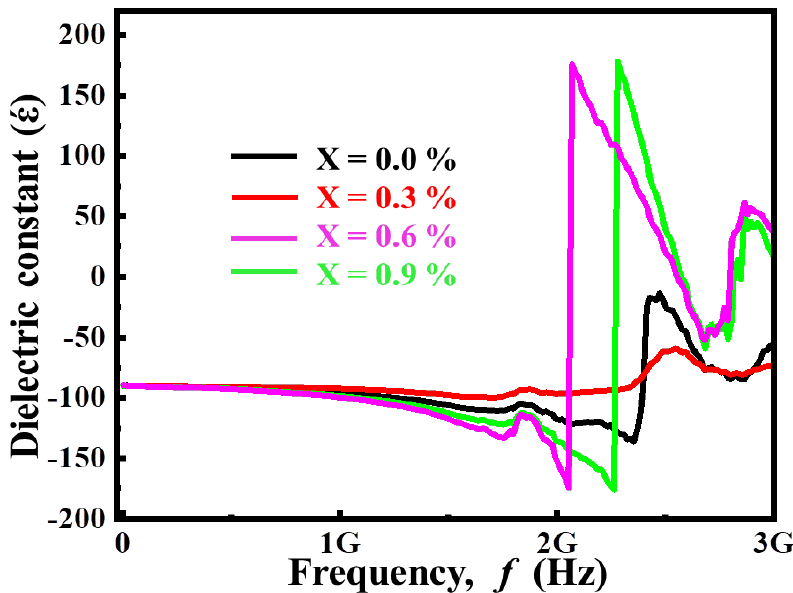
Figure 2. Variation of dielectric permittivity with frequency for (Ba 1−x Ca x )Ti 4 O 9 (x = 0.0, 0.3, 0.6 and 0.9) sintered ceramics at 1000 °C for 4 h.